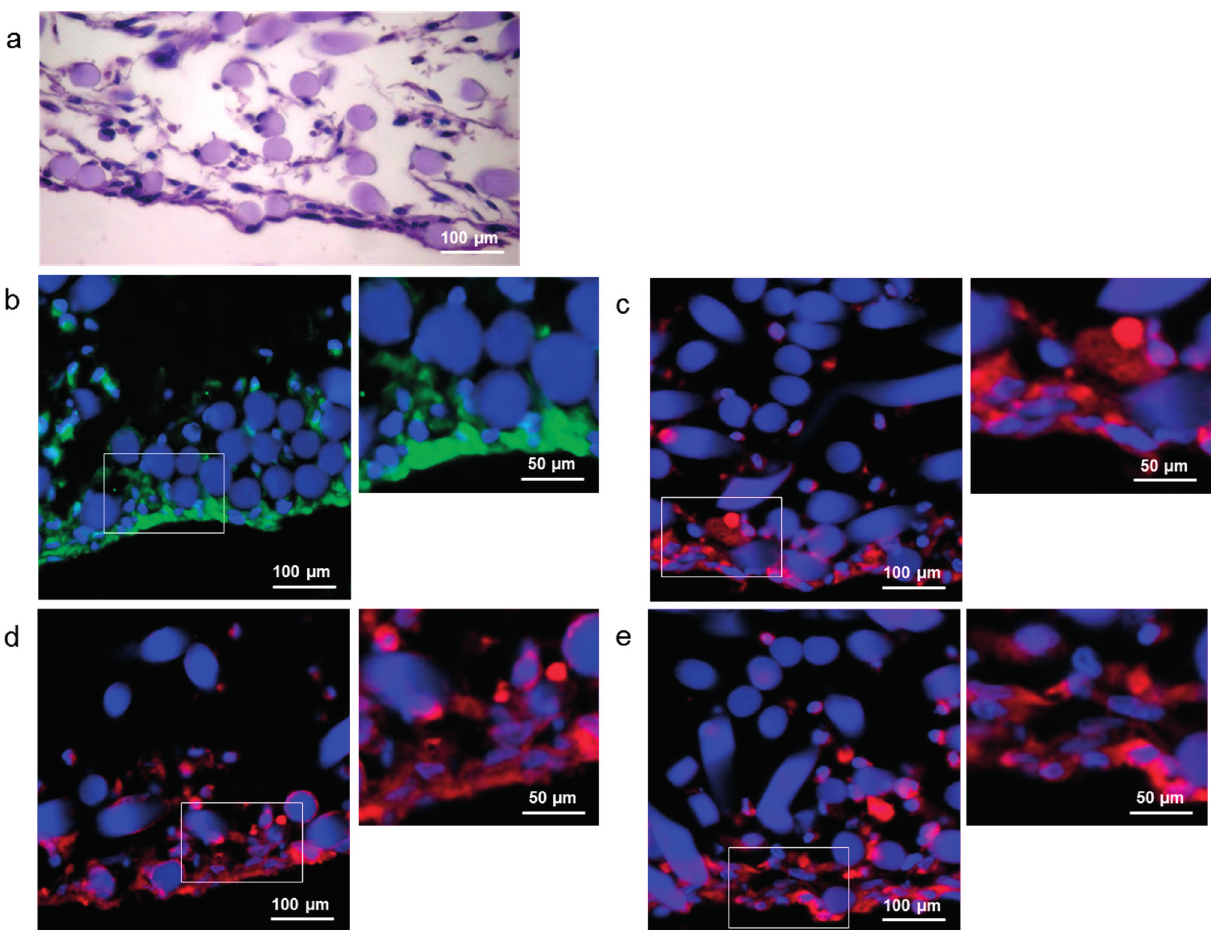
Figure 2. DPSCs seeded onto hyaluronan-based scaffolds and cultivated with differentiation medium for 21 days. ( a ) H/E staining; Fluorescence images of cells expressing ( b ) collagen type I (green), a component of the extracellular matrix (ECM); ( c ) Von Willebrand factor (red), an endothelial marker; ( d ) Beta-III Tubulin (red), a neuronal marker; and ( e ) GFAP (red), a glial marker. Cell nuclei and the biomaterial are stained